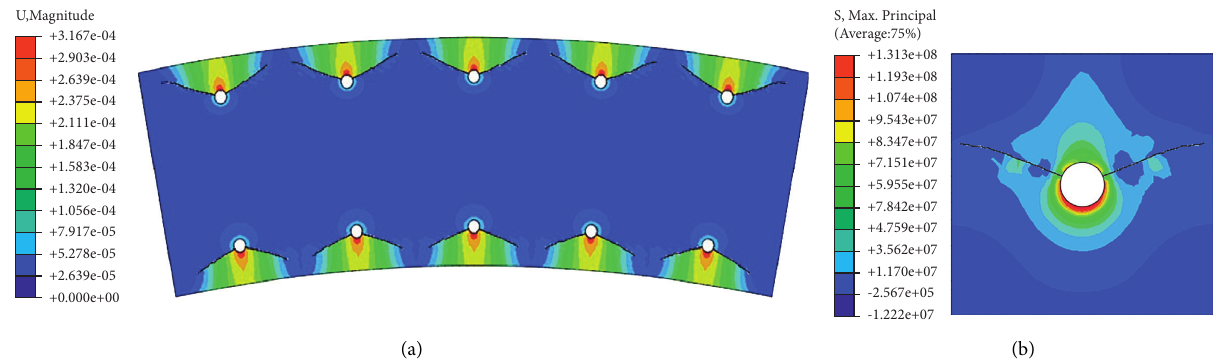
Figure 15: Degradation characteristics of the segment after 10 years of steel bar corrosion: (a) the displacement cloud during cracking and (b) the maximum principal stress cloud during cracking.